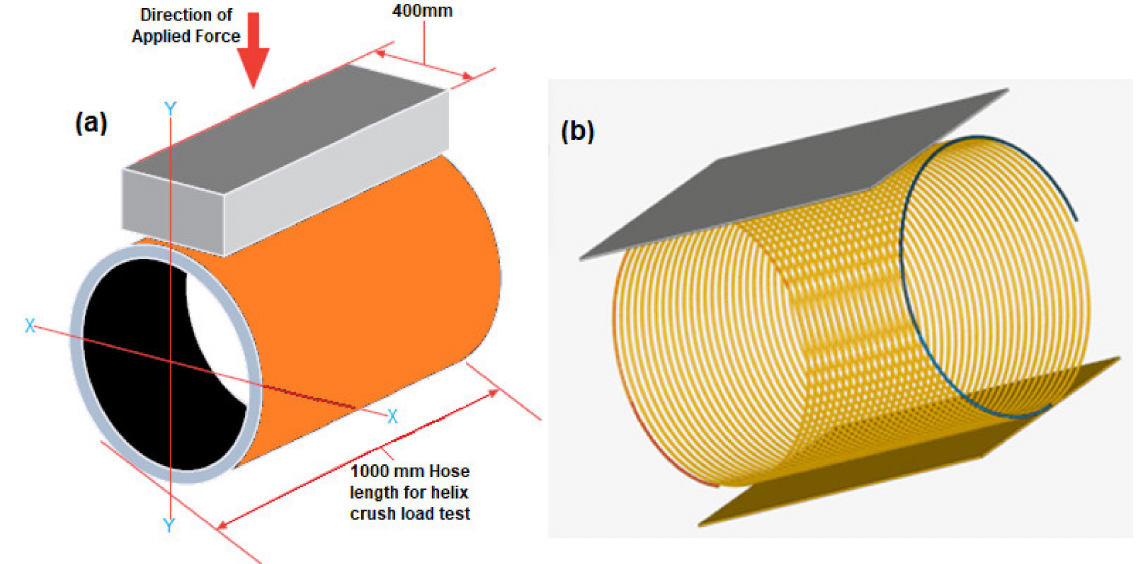
Figure 9. Reinforcement helix model compression, showing ( a ) hose crush load and ( b ) FEM of